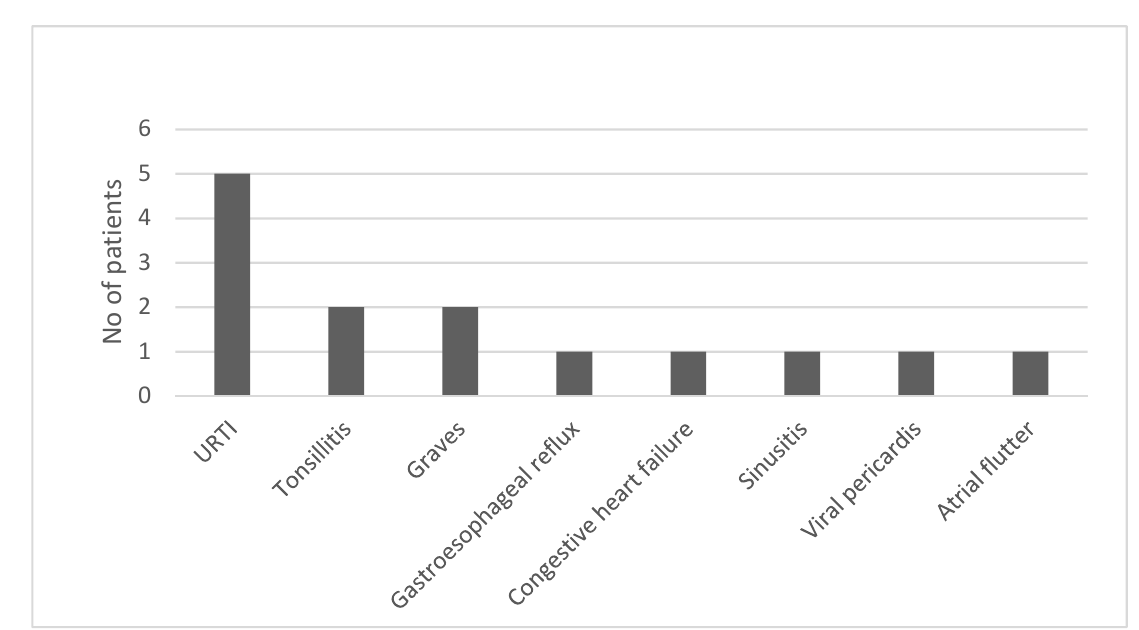
Figure 3. Initial alternative diagnoses ( n = 38) .